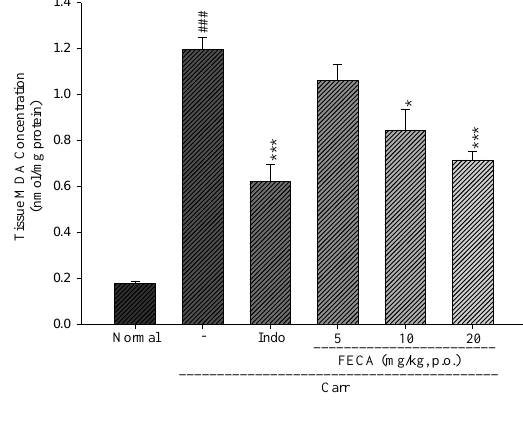
mice. Each value represents as mean ± S.E.M. ### p < 0.001 as compared with the normal group; * p < 0.05; *** p < 0.001 as compared with the λ-carrageenan (Carr.) group